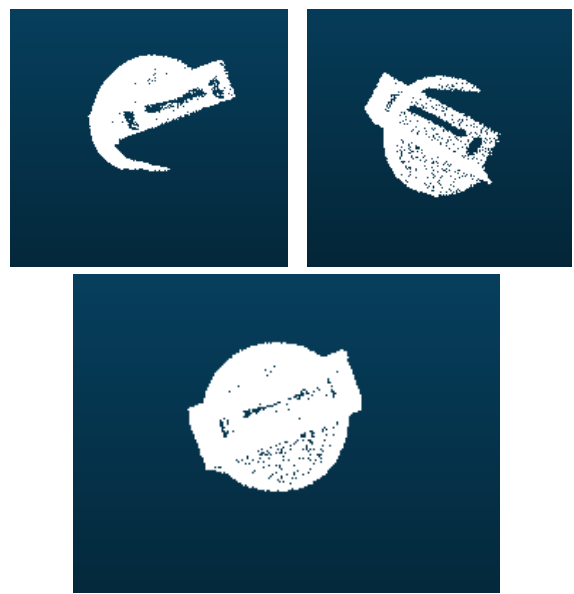
Figure 14: Point clouds before and after transformation.